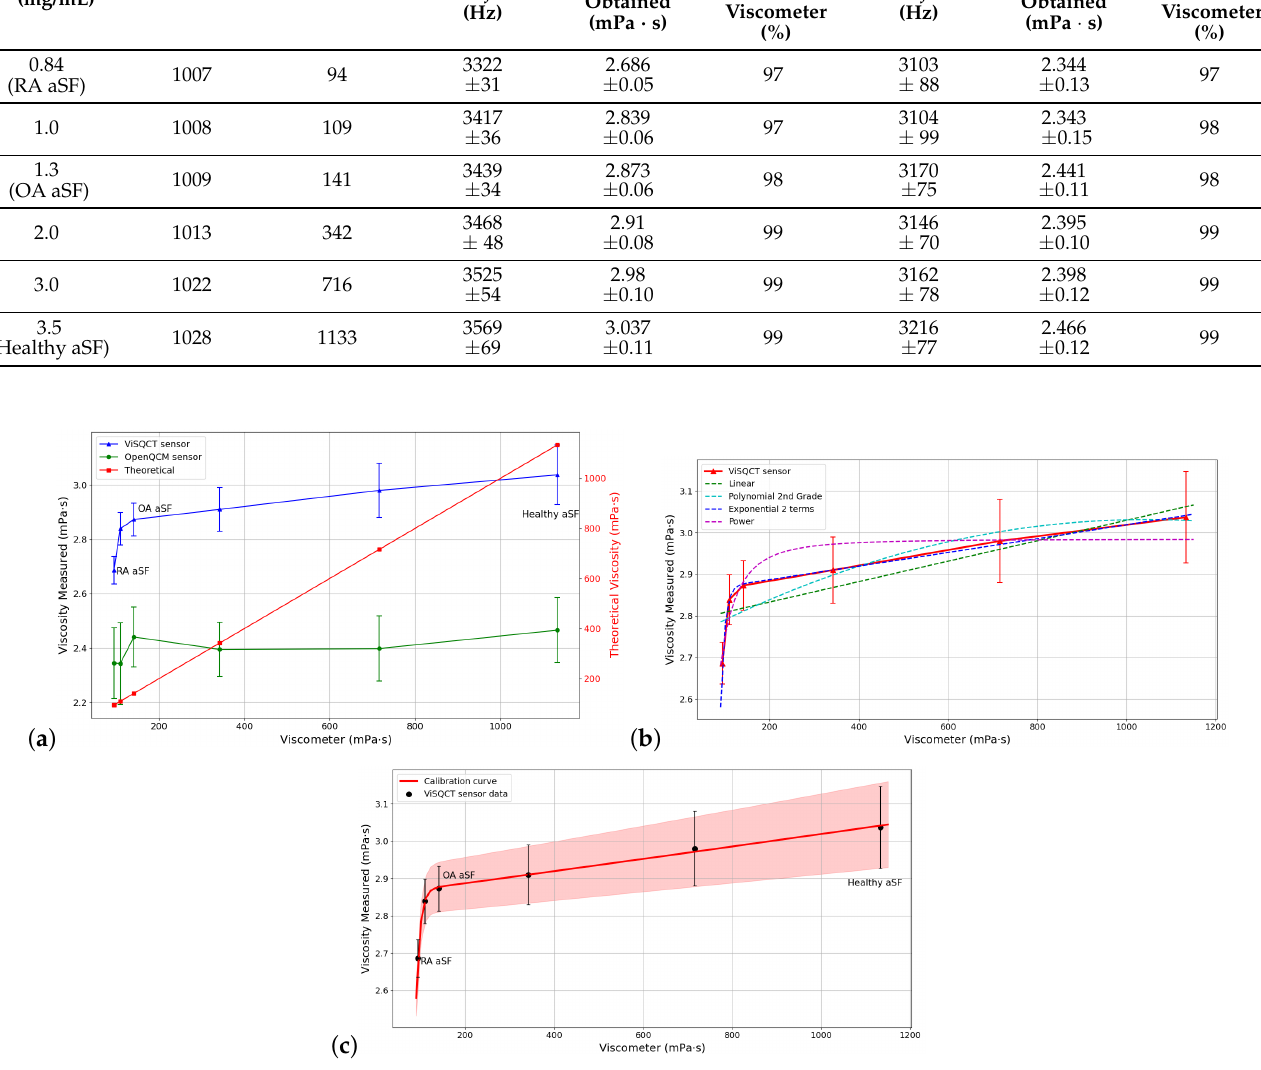
Figure 6. ( a ) Comparison of measured viscosities for aSF using the two sensors and the rotational viscometer. ( b ) Adjustment with different functions for aSF. ( c ) Calibration curve for